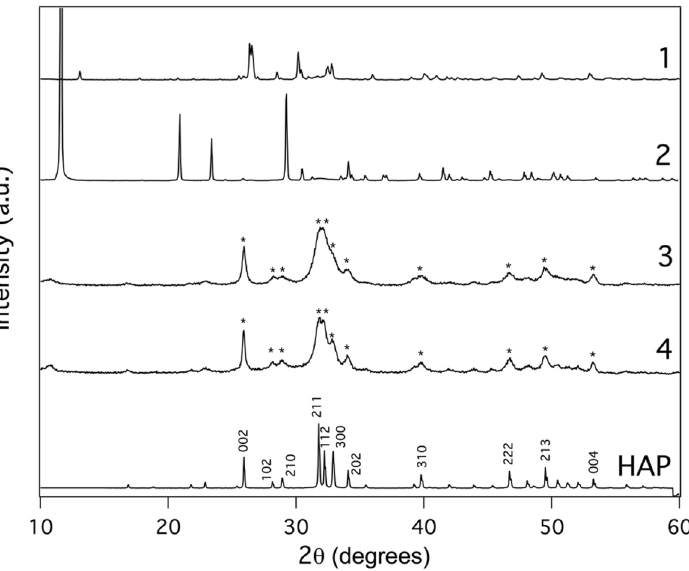
Figure 1. XRD patterns of the particles obtained from the syntheses 1, 2, 3 and 4 and a pattern of HAP standard purchased from Sigma Aldrich. The symbol “*” indicates the typical peaks of hydroxyapatite (JCPDS no.